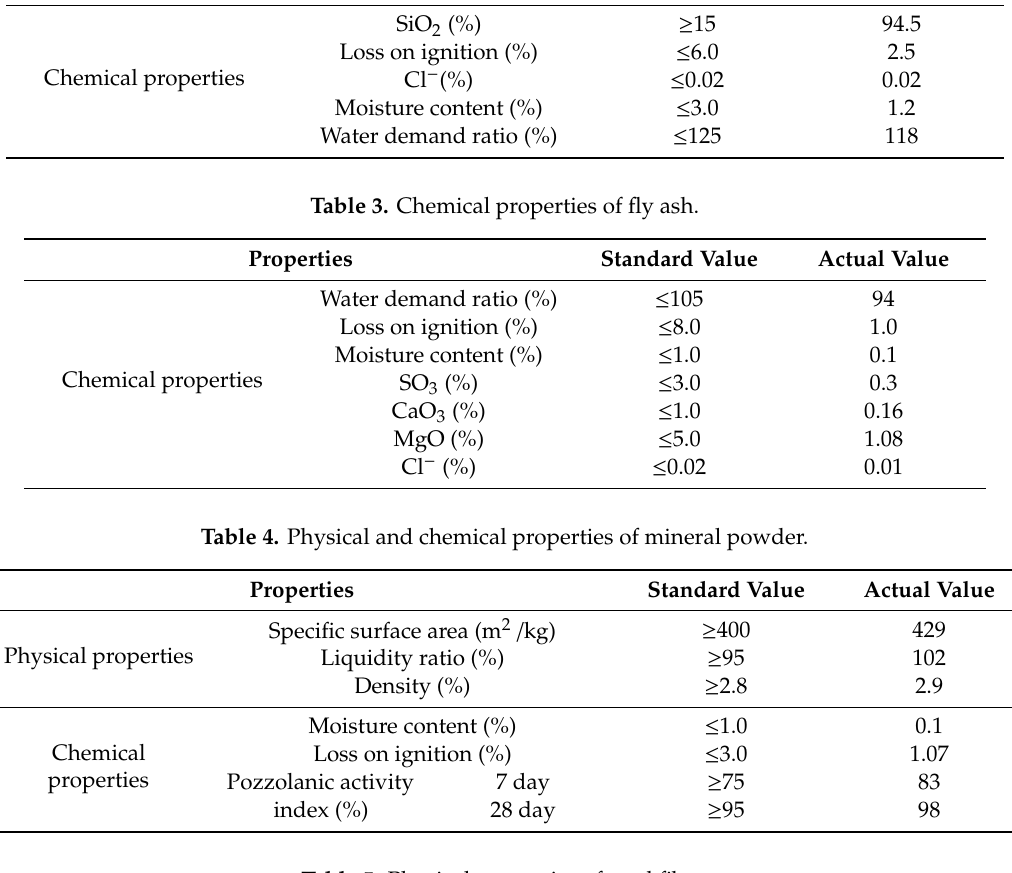
Table 5. Physical properties of steel